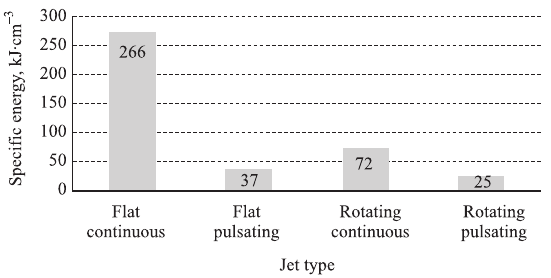
Fig. 9. Specific energy required for disintegration of 1 cm 3 of concrete for tested jet types (water pressure: 30 MPa, traversing velocity: 0.2 m.min –1